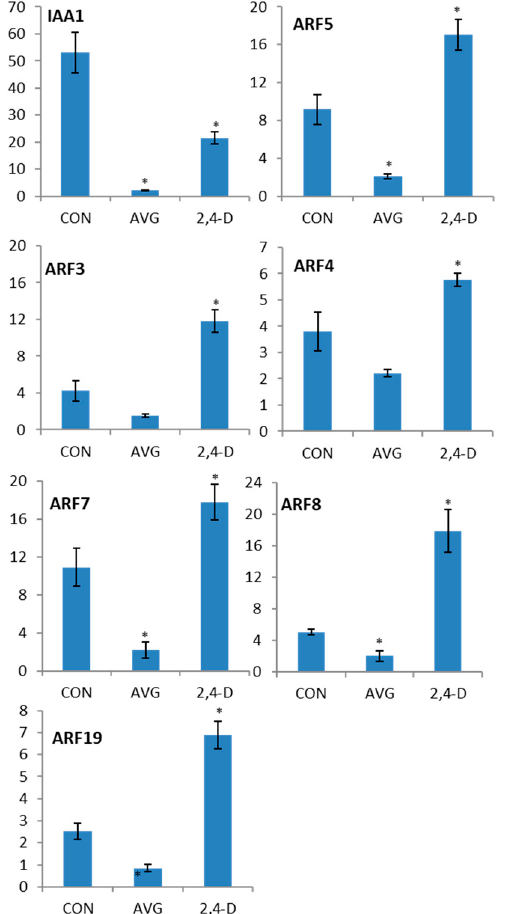
Figure 5. Auxin regulation of ARF gene transcript levels. The left bar indicates expression in untreated control seedlings, the middle bar indicates expression in seedlings after a 28 h AVG treatment, and the right bar 28-h AVG treatment followed by 4 h of 2,4-D treatment. All values on the y axes are expressed in terms of transcript abundance relative to the control gene APT1 . IAA1 is used as a positive control based on well-known auxin inducibility. Student’s T-test, significant p -values ( < 0.05) are indicated by asterisks. Error bars represent standard deviations.